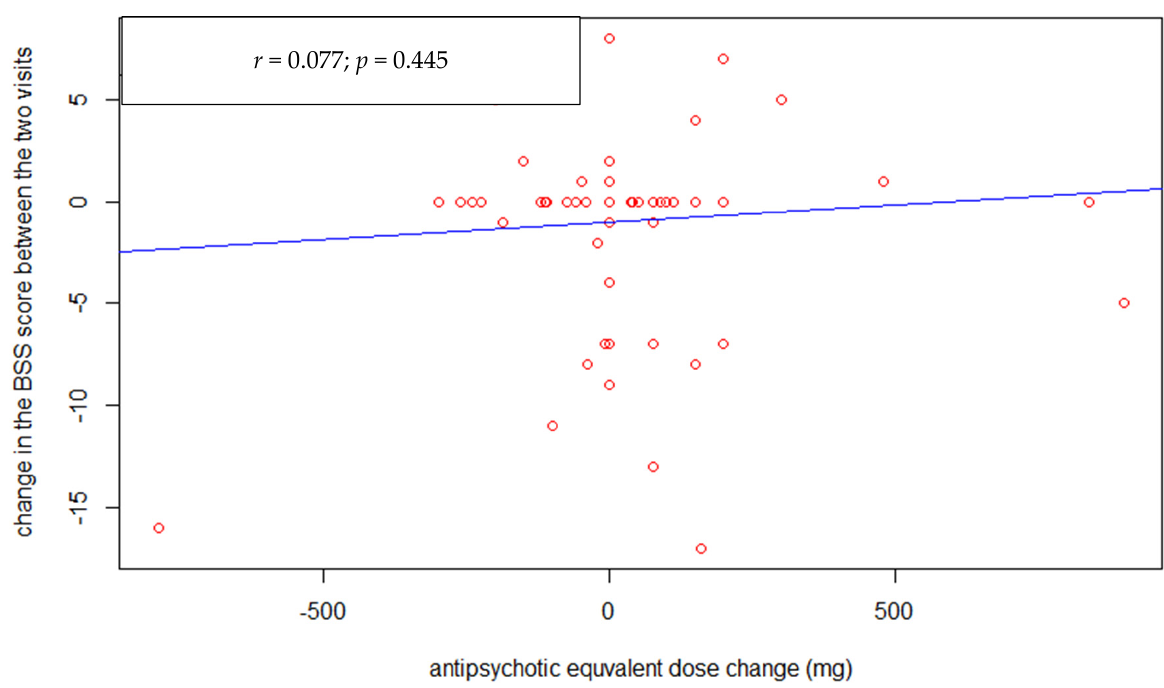
Figure 2. Correlation between BSS and chlorpromazine equivalent (CPZe) changes.